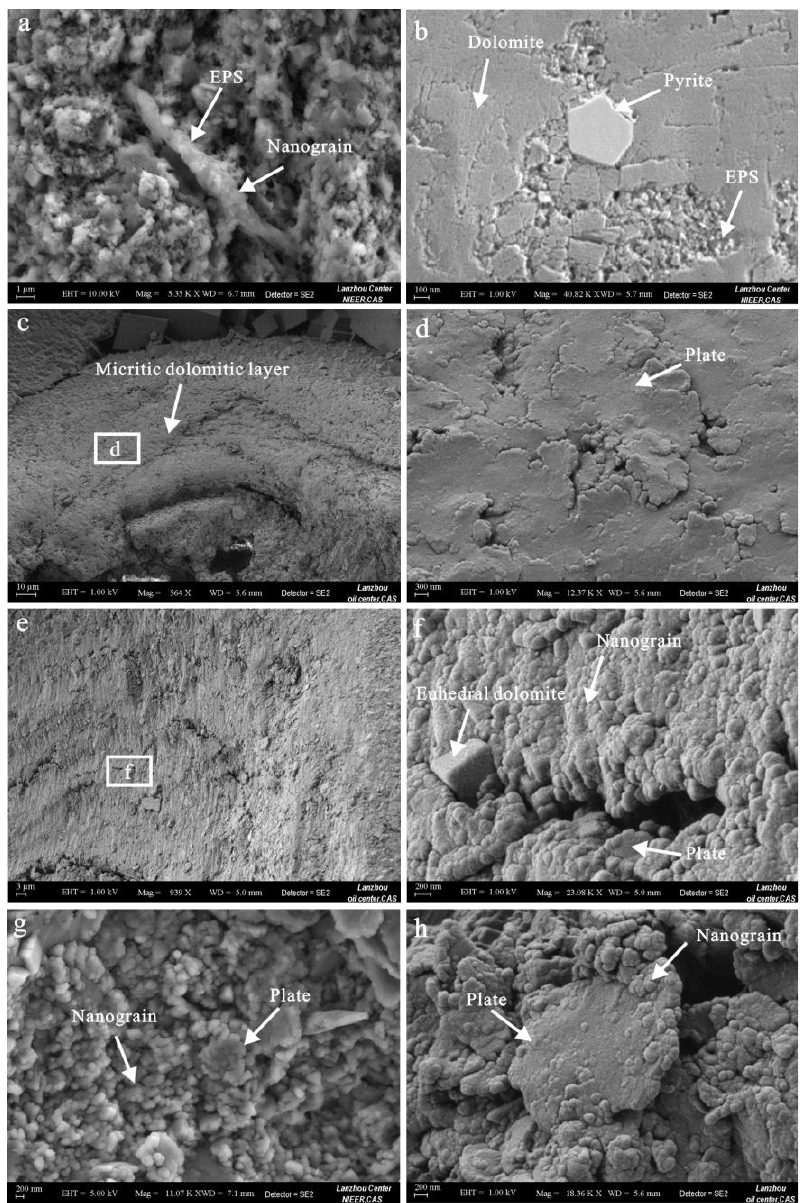
Figure 8. SE images of the ooids taken by scanning electron micrographs. ( a ) EPS occurs in the ooid cortices, where dolomite is within the EPS with a nanograin pattern; ( b ) all together, dolomite, EPS, and pyrite occur in the same area; ( c ) SEM image shows stacked dolomitic layers; ( d ) layer consists of dolomitic plates, which present deformation due to collision; ( e ) SEM image shows concentric laminations; ( f ) nanograins aligned parallel to the laminae, and the euhedral dolomite crystal was developed between layers; ( g ) dispersed nanograins and embryonic form of the plate; ( h ) dolomitic plate morphologies and nanograins along the edges of the plate.